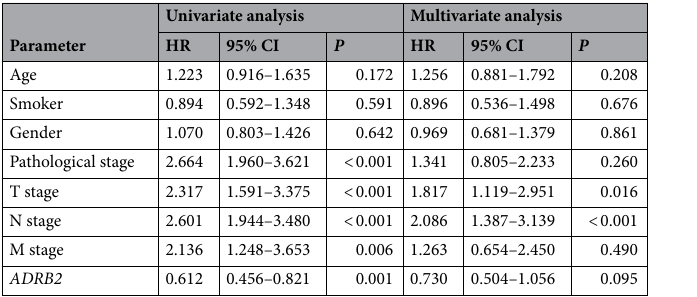
Table 2. Univariate and multivariate analyses of ADRB2 and clinical pathological parameters associated with survival in patients with